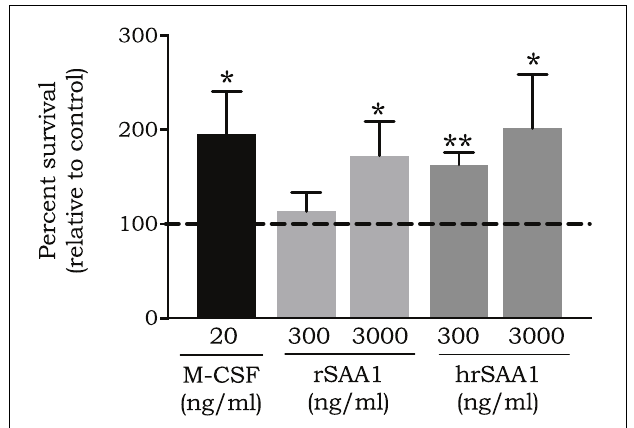
FIGURE 7 | hrSAA1 promotes the survival of monocytes. Freshly isolated monocytes were treated with hrSAA1 (300 or 3000 ng/ml, 25 or 250 nM), rSAA1 (300 or 3000 ng/ml, 25 or 250 nM), M-CSF (20 ng/ml, 0.54 nM) or left untreated (control) for a period of 24 h. Following stimulation, ATP levels were detected using firefly luciferase luminescence. Control survival is indicated by a dashed line (---). Results are presented as the mean percent of survival in comparison to control + SEM and are derived from five independent experiments. Significant survival in comparison to control is indicated by asterisks (Mann-Whitney U -test; * p -value < 0.05, ** p- value < 0.01).